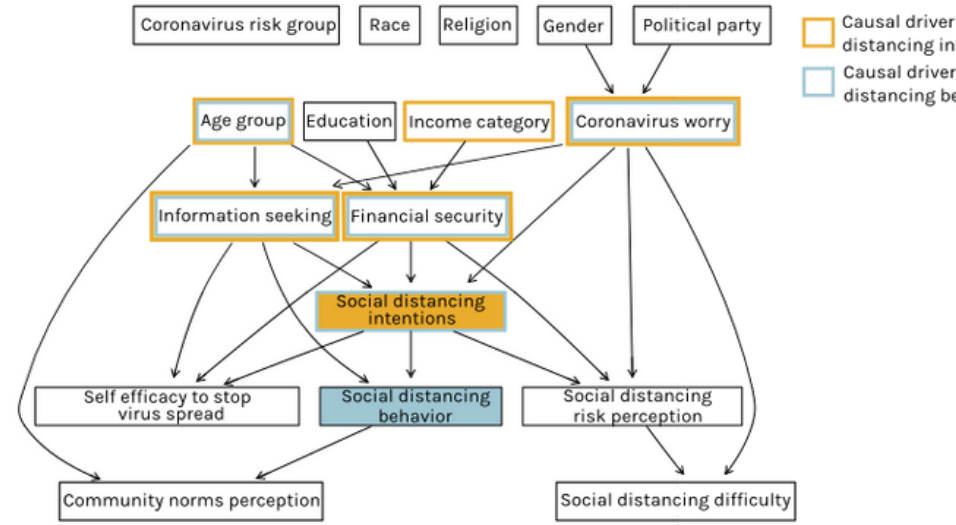
Figure 3 . Structural graph depicting the causal relationships between respondent demographics, beliefs, and social distancing outcomes. Outcome of interest, social distancing behavior, is highlighted in blue. All significant direct causal drivers of social distancing behavior are outlined in blue, and all significant direct causal drivers of social distancing intentions are outlined in